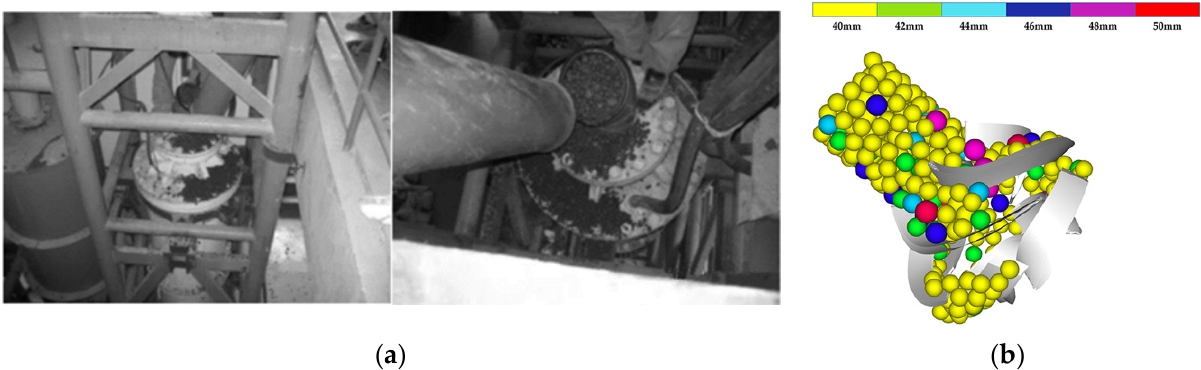
Figure 7. Particle reflux experimental and simulation comparison: ( a ) 40–50 mm particle reflux experimental; ( b ) simulation of 40–50 mm particle reflux.